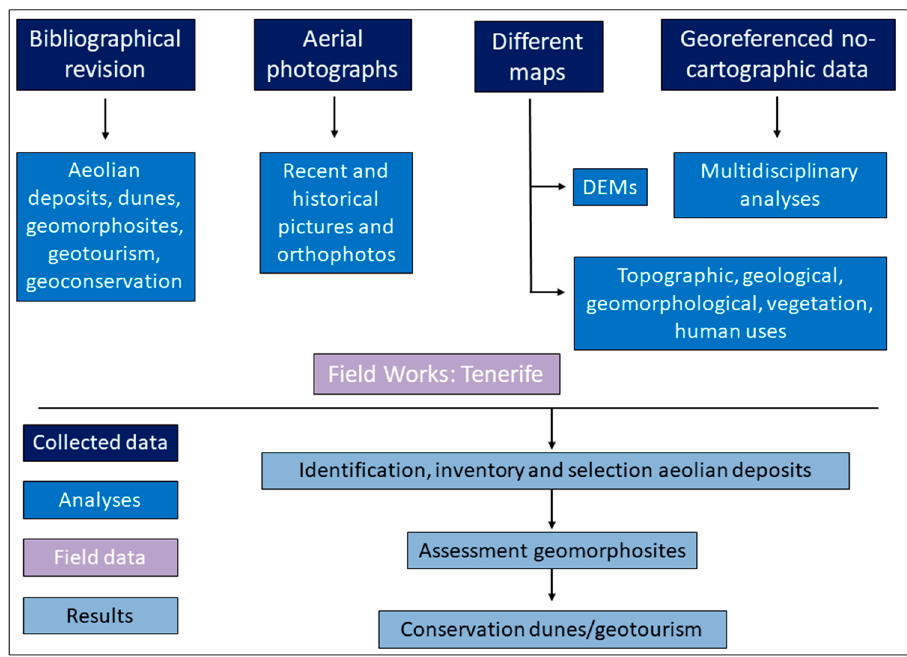
Figure 2. General methodology applied in this study.